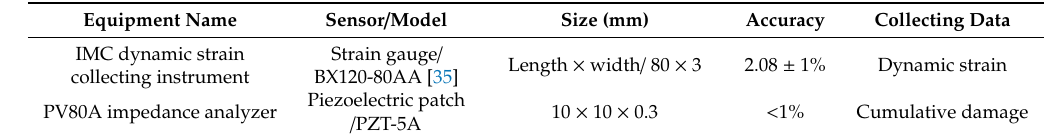
Table 5. Mix proportion of concrete.